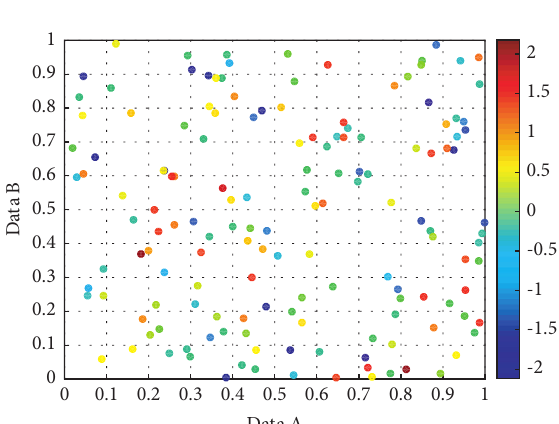
Figure 6: Analysis result.